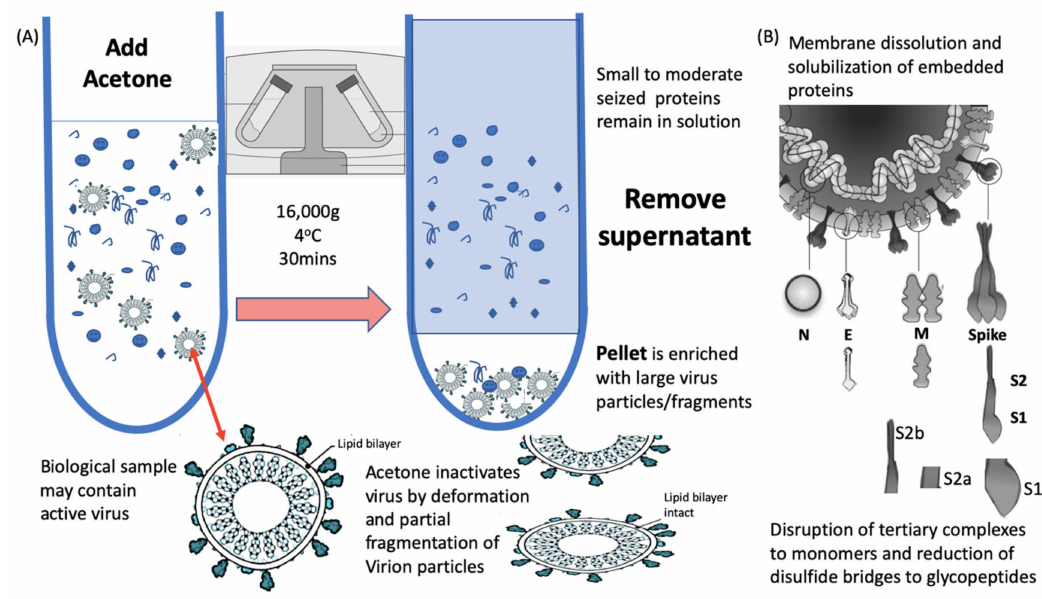
Figure 2. Process of virion enrichment within a biological sample and extraction / solubilisation of Spike (S) and other viral envelope protein for MALDI ToF MS analysis. Panel ( A ): Biological samples containing virus are mixed 1 to 1 v / v with ice cold acetone and centrifuged at 16,000 × g for 30 min at 4 ◦ C. The supernatant containing smaller non-precipitated solutes is discarded. The pellet is enriched with viral particles and kept for analysis. Acetone treatment inactivates envelope virus by deformation and partial fragmentation of the viral envelope and embedded protein Structures A. Panel ( B ): The pellet is resuspended in 10 to 100 uL of MALDI -ToF Mass spectrometry compatible dissolution and solubilisation bu ff er. Termed LBSD-X this bu ff er does not suppress ionisation and contains a detergent at a concentration optimised to release viral envelope embedded proteins together with non-embedded viral proteins. It also contains Dithiothreitol (DTT) in order to further reduce disulphide bonds so that quaternary and tertial structures are fully disrupted and monomers, polypeptide chains and glyco-polypeptides are liberated for detailed mass